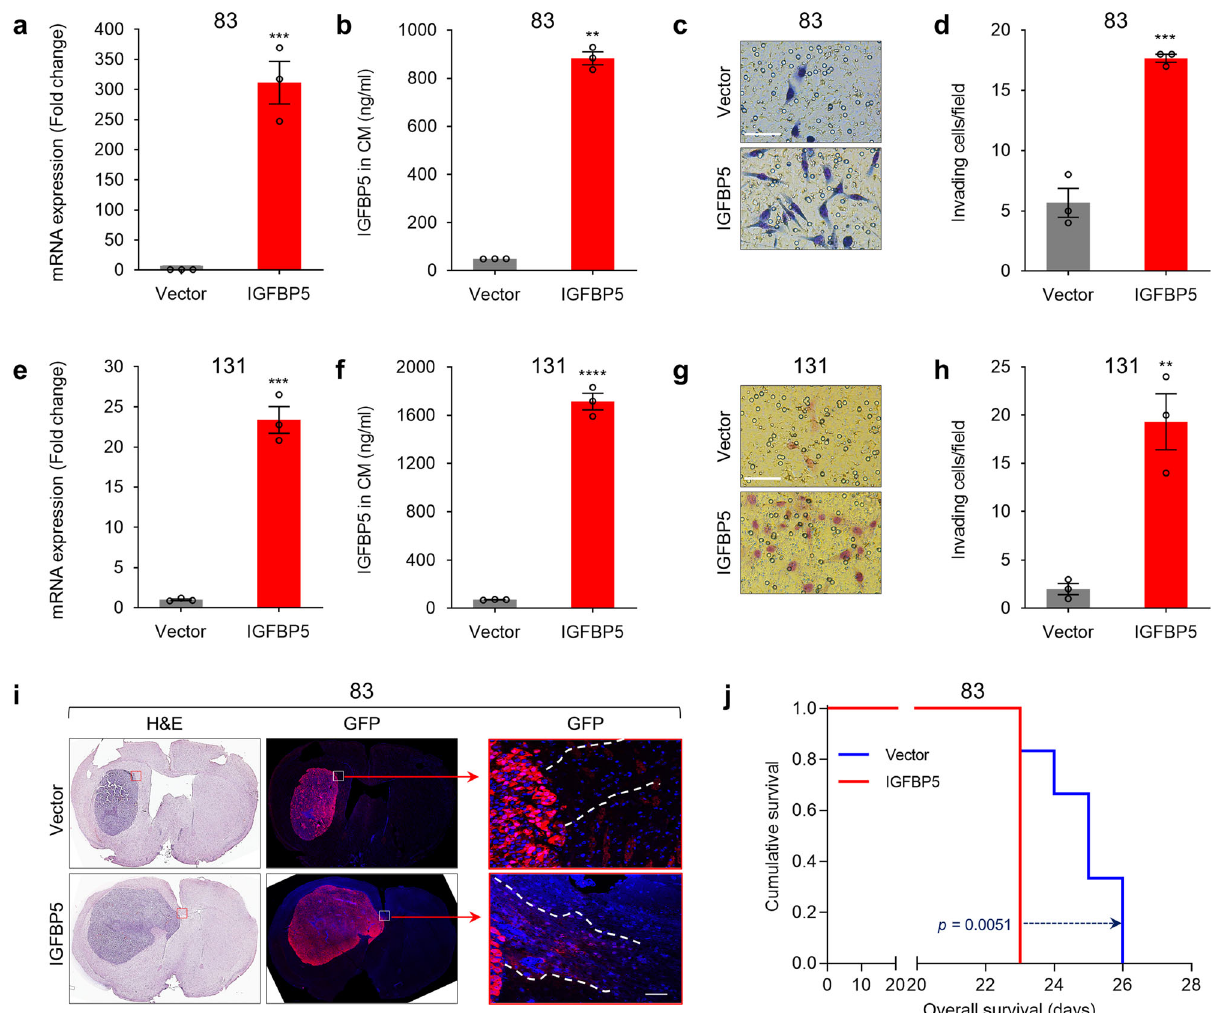
Fig.3|EctopicIGFBP5overexpressionenhancesinvasionandtumorigenesisof non-invasive GSCs. a RT-qPCR analysis of IGFBP5 expression in 83 GSCs